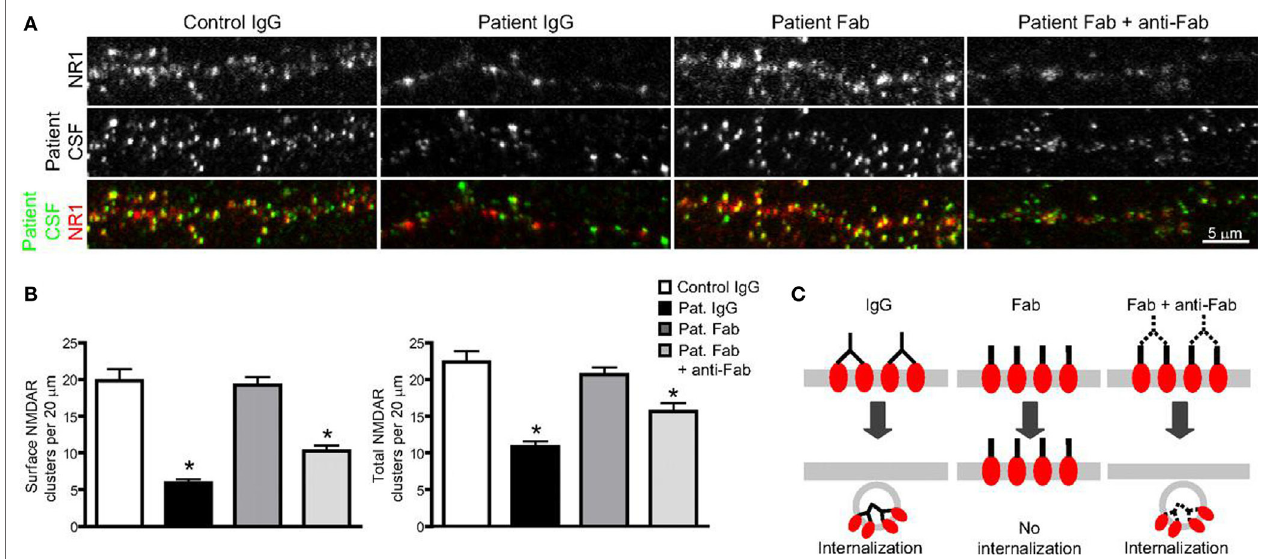
FiGURe 2 | The binding, crosslinking, and internalization of autoantibodies to N -methyl- d -aspartate receptor (NMDAR) . (A) Surface and total NMDAR clusters are immunostained. Treatment with patients’ autoantibodies leads to a decrease of NMDAR cluster both in surface and total (middle left). Treatment with only Fab fragment does not influence the density (middle), while combination with Fab fragments and anti-Fab secondary antibodies together decrease cluster again both in surface and total (middle right). (B) Statistical analysis of the effects on surface and total NMDAR cluster density of three different treatments. (C) The outline that shows the effect of treatments on surface receptor clusters (74). Copyright permission from the correspondence, Dr. Rita J. Balice-Gordon.